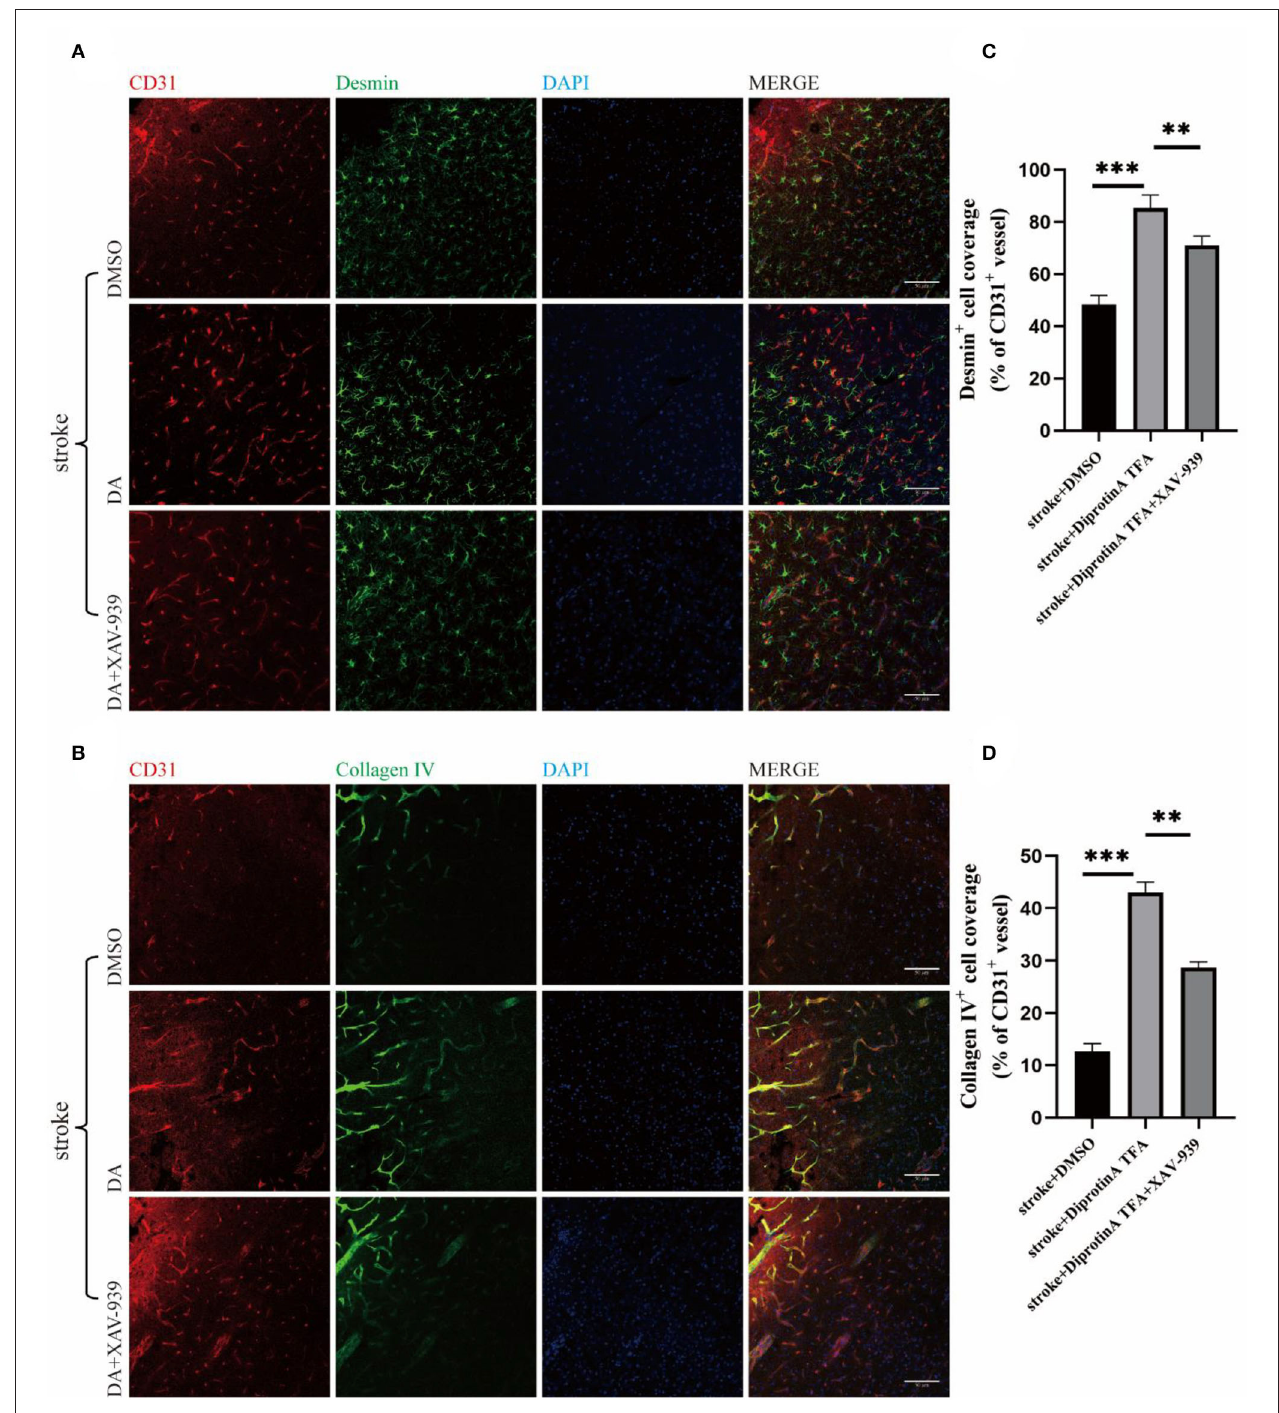
FIGURE 5 | Diprotin A TFA increases vascular-pericyte and endothelial basement membrane coverage in peri-infarct cortex. (A) Immunofluorescent staining images of CD31 (red) and desmin (green) (desmin, labeled pericytes) co-staining. The slice thickness is 40 µ m. Bar = 50 µ m. (B) Immunofluorescent staining images of CD31 (red) and collagen IV (green) (type IV collagen, labeled basement membrane) co-staining, with a section thickness of 40 µ m. Bar = 50 µ m. (C) A statistical plot of vascular pericyte coverage. (D) A statistical plot of vascular endothelial basement membrane coverage. Compared with the vehicle control group, it can be seen that the coverage rate of stained vascular pericytes in the DA injection group was increased compared with the vehicle control group. Vascular endothelial basement membrane coverage results were the same as above. n = 3 per group. Data are represented as mean with SEM. ** p < 0.01, *** p < 0.001.